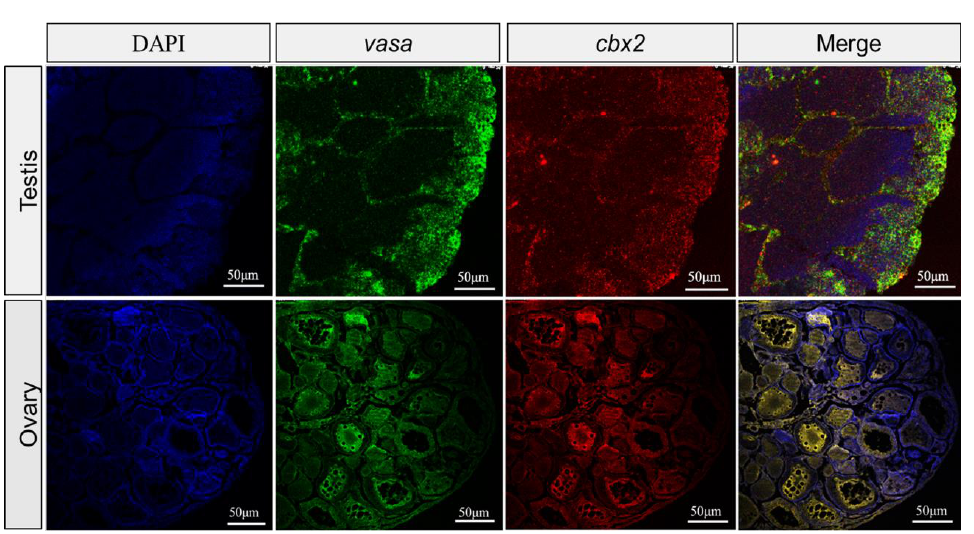
Figure 6. Fluorescent in situ hybridization (FISH) in medaka ovaries and testes. The mRNA signals were stained with fluorescence, with green indicating vasa and red indicating cbx2, and the nuclei were dyed with DAPI (blue).